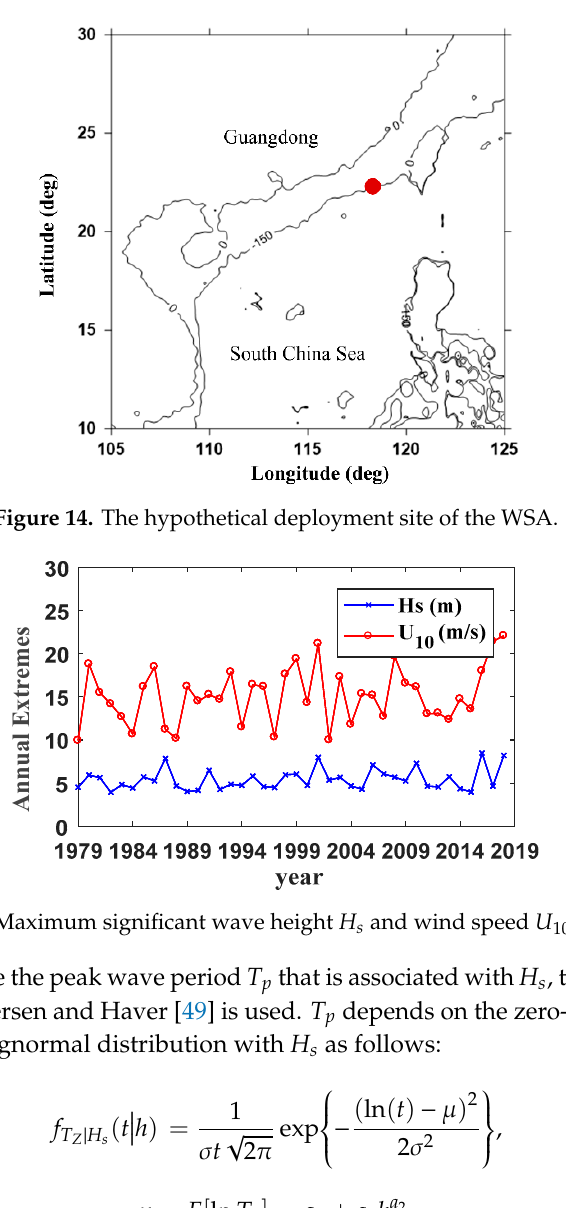
Figure 14. The hypothetical deployment site of the WSA.